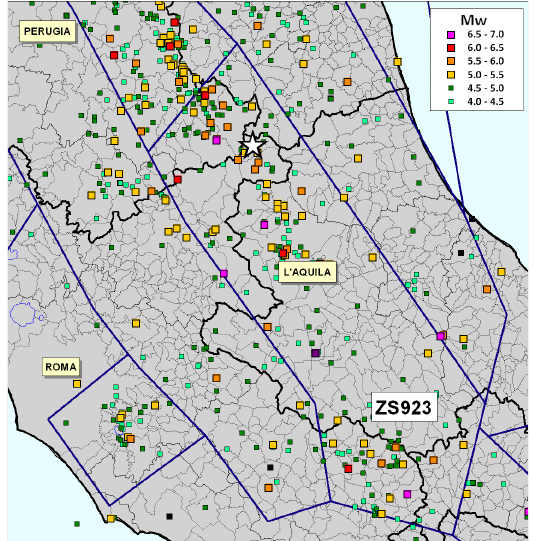
Figure 2. Seismic source zones of the ZS9 model (blue lines) and earthquakes from the CPTI04 catalogue (mo- ment magnitudes mainly derived from historical data). White star is the epicenter of the 24 August 2016 Mw 6.0